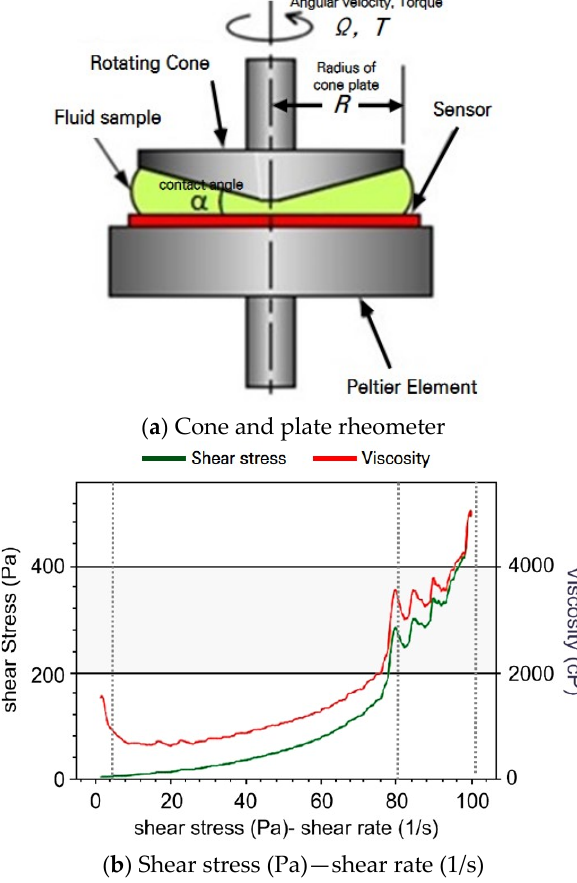
Figure 2. Cone and plate rheometer and rheological behavior results of STF ‐ based stemming.